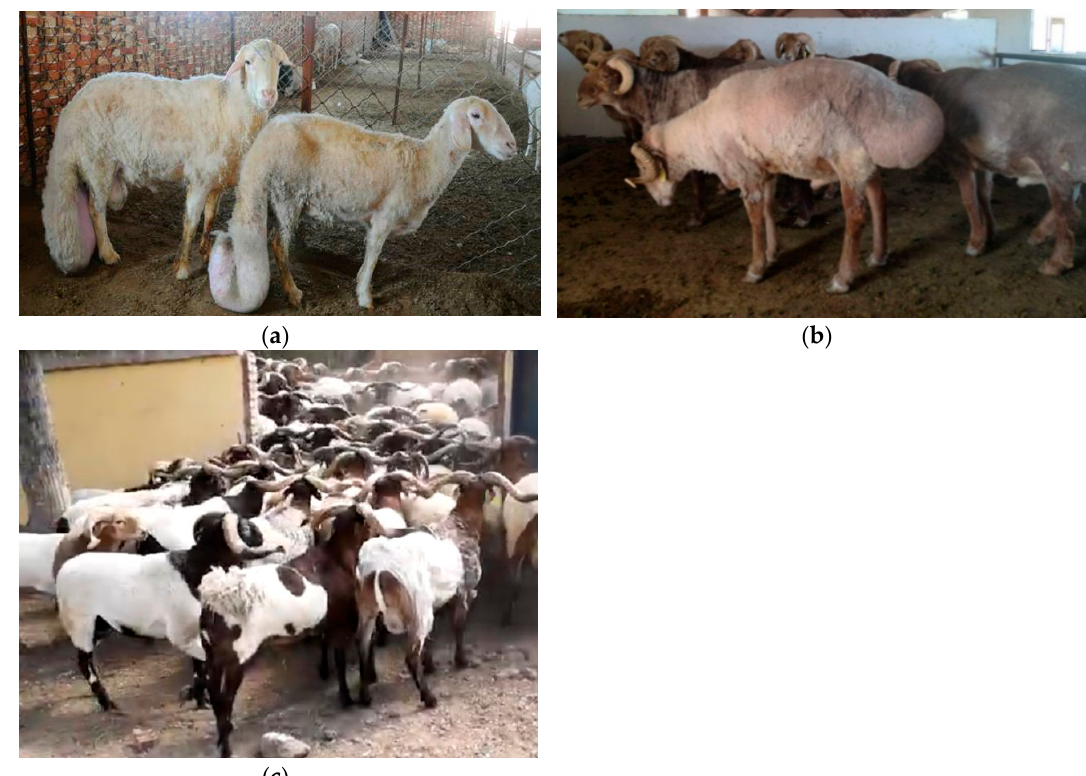
Figure 1. Chinese indigenous sheep breeds with three different tail types: ( a ) Large-Tailed Han sheep, ( b ) Altay sheep, and ( c ) Tibetan sheep.